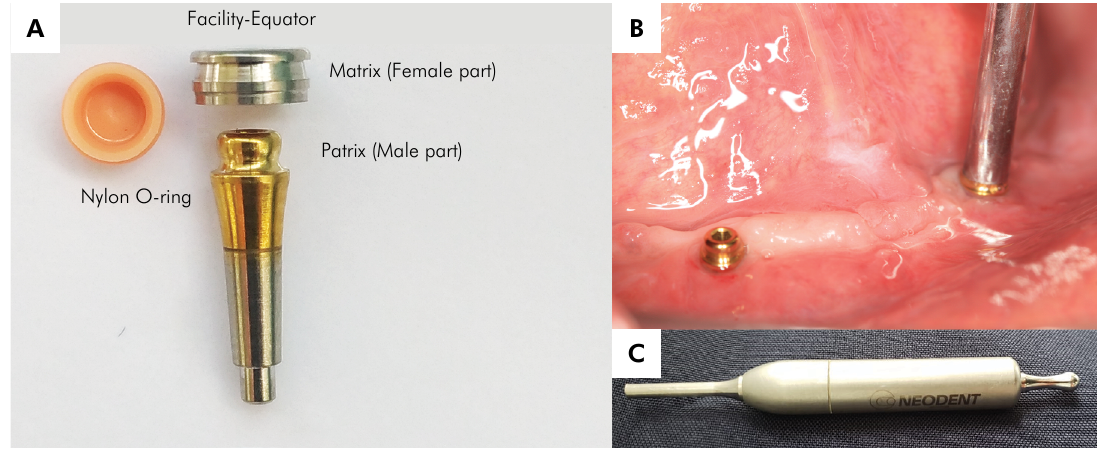
Figure 1. Facility-Equator attachment system: a) Facility-Equator Attachment, O-ring with cylinder, O-ring Equator pink; b) intra-oral view of the Equator attachment; c) Facility abutment placement